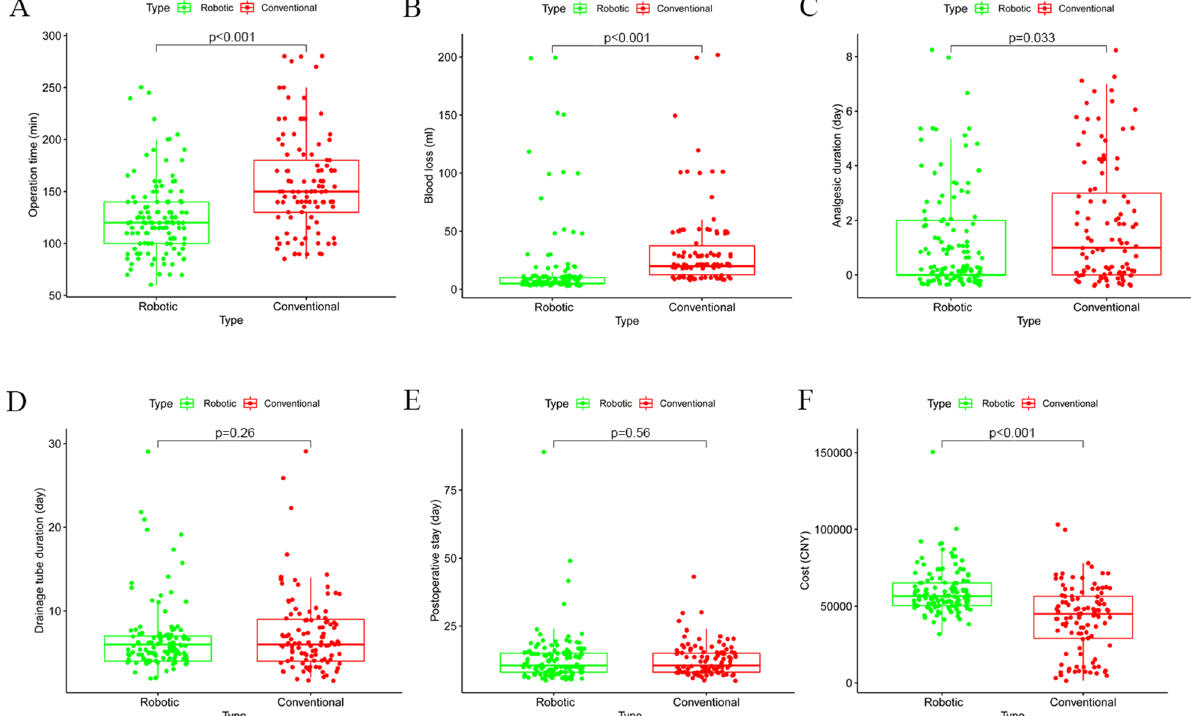
Figure 2. Comparison of perioperative outcomes between patients with the two different surgery approaches (( A ) operation time; ( B ) blood loss; ( C ) analgesic duration; ( D ) drainage tube duration; ( E ) postoperative stay; ( F ) total hospitalization costs). According to t-test or Mann–Whitney test.